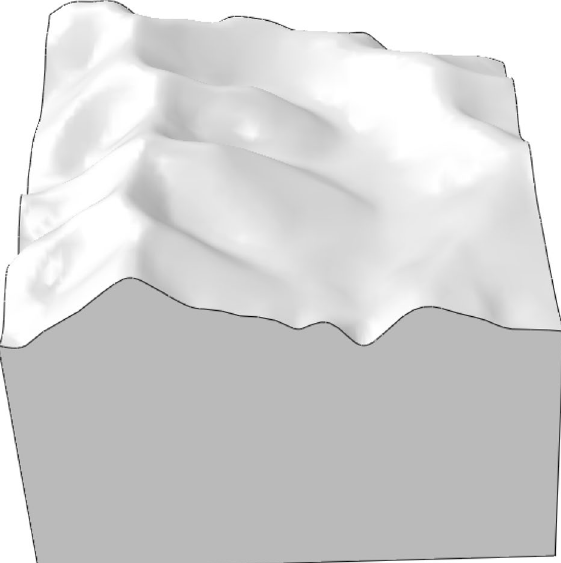
Figure 1. Original terrain of Lijiazhai slope before